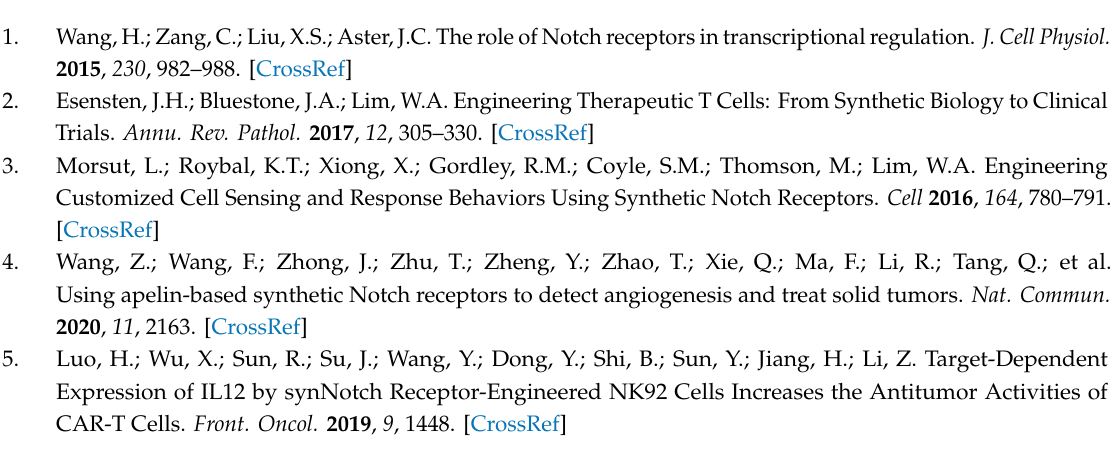
Figure S1: Flow cytometry analyses of DsRed-Express fluorescence of all used synNotch constructs after unspecific activation with HEK293 cells for all investigated ratios; Figure S2: Flow cytometry analyses of DsRed-Express fluorescence of all used synNotch constructs after unspecific activation with HEK293 cells for all investigated time points; Figure S3: Flow cytometry analyses of DsRed-Express fluorescence of all used synNotch constructs during ongoing culture over 8